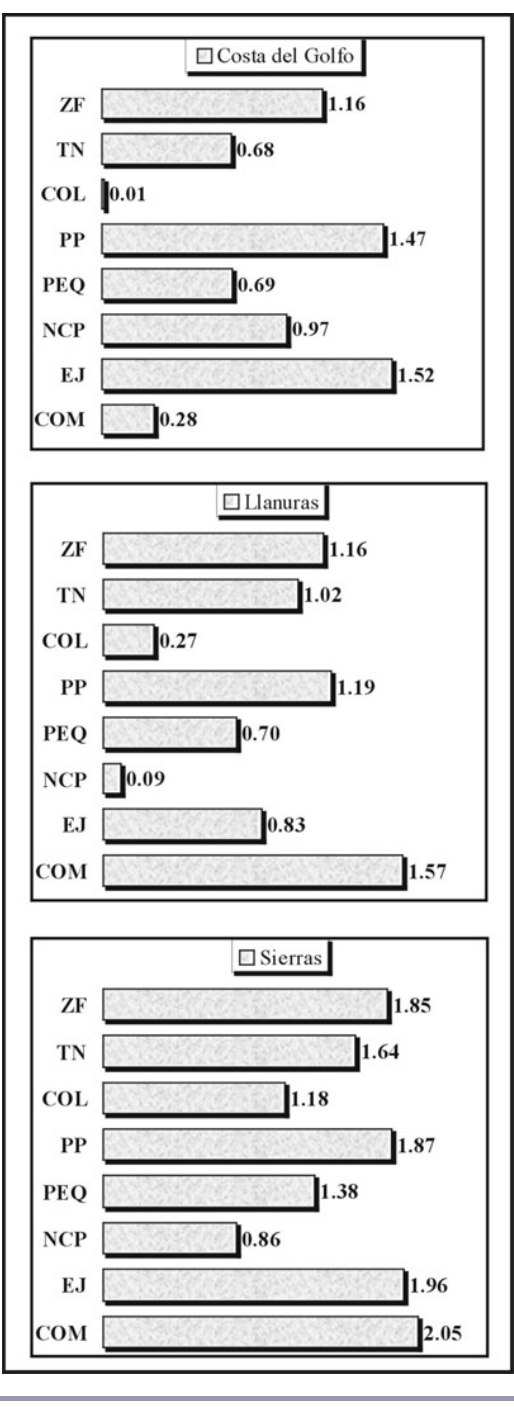
Fig. 3. Shannon’s Diversity Index of remaining natural vegetation by land ownership types at three subregions: Costa del Golfo, and Llanuras y